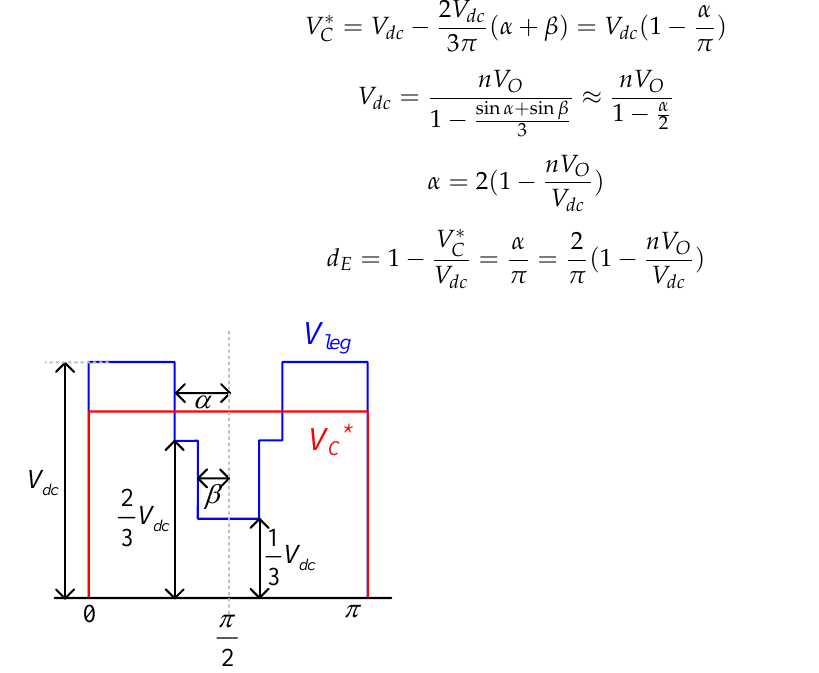
Figure 12. Relationship between V C * and V leg